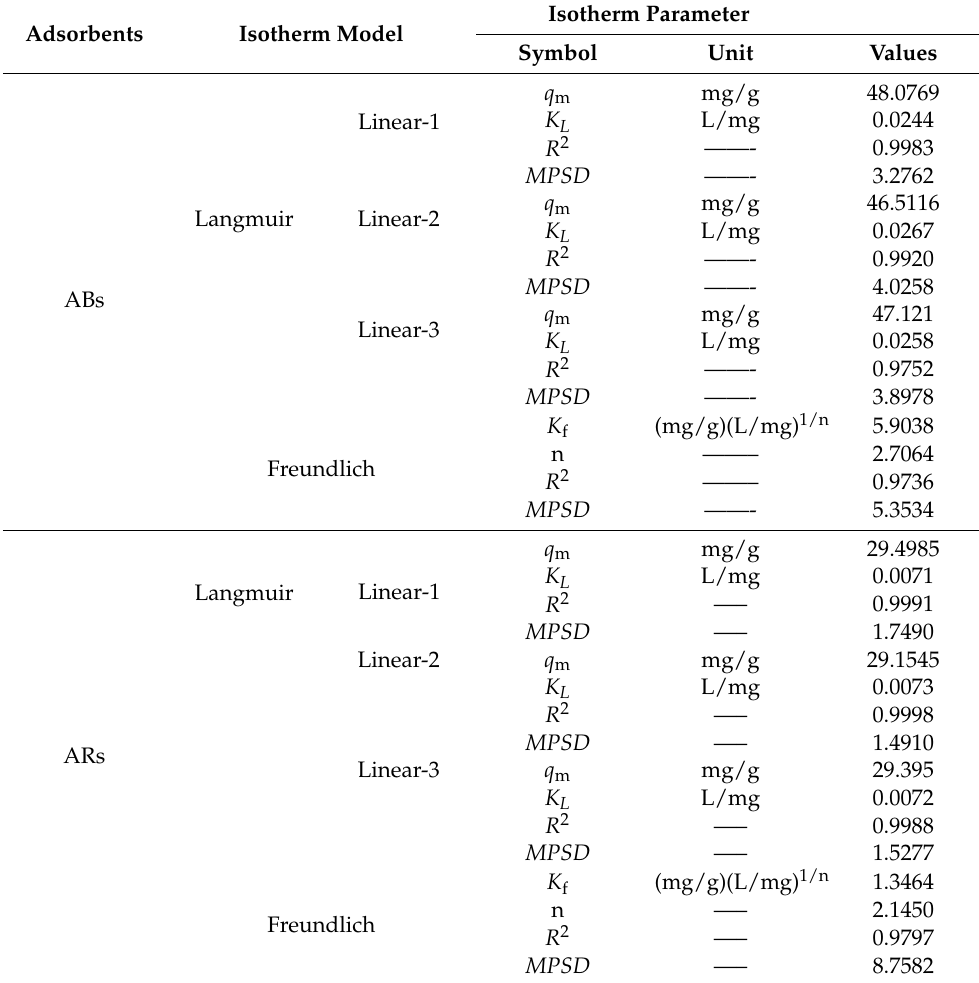
Table 4. Correlation coefficient and isotherm parameter values of different isotherm models.